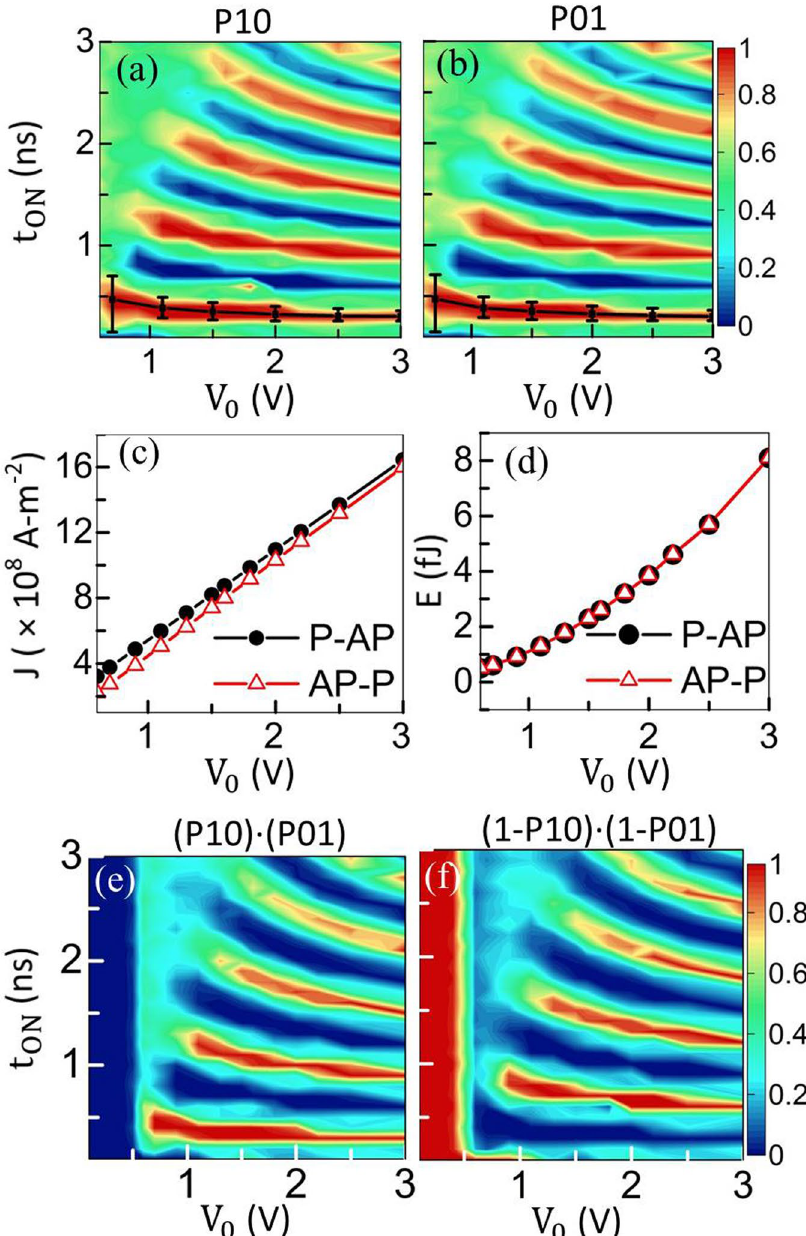
Figure 3. Phase diagram of switching probability from ( a ) parallel (P) to anti-parallel (AP) state (P10) and from ( b ) AP-to-P (P01) as a function of t ON and V 0 at t MgO of 2 nm and μ 0 H x of 50 mT (with thermal fluctuation). The black bars show the t ON operation windows without considering thermal fluctuation. The increasing operation window as V 0 decreases indicates that the device favors a low-voltage operation. ( c ) Current density and ( d ) energy consumption per switch vs . V 0 . ( e ) Switching probability from P-to-AP ‘AND’ AP-to-P (P10 ⋅ P01) as a function of t ON and V 0 . Red regions indicate deterministic switching, i.e. 100% certainty of toggling. ( f ) Retention probability, i.e. (1-P10) ⋅ (1-P01) as a function of t ON and V 0 . Red regions show with 100% probability that pre-configured data would not be